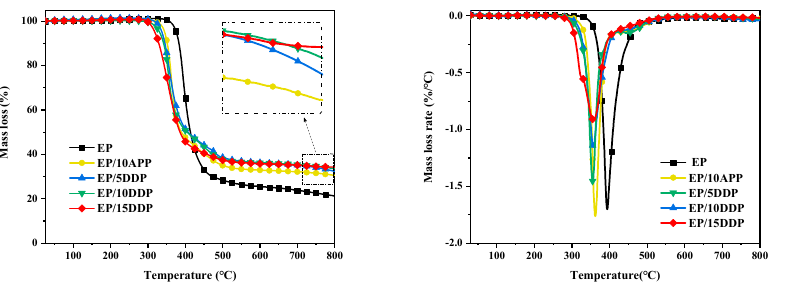
Figure 6. TG and DTG curves of flame ‐ retarded EP blends at a heating rate of 10 °C min − 1 in a nitrogen atmosphere. Table 2. Thermal parameters of the flame ‐ retarded EP blends under a nitrogen atmosphere at a heating rate of 10 °C/min. Samples